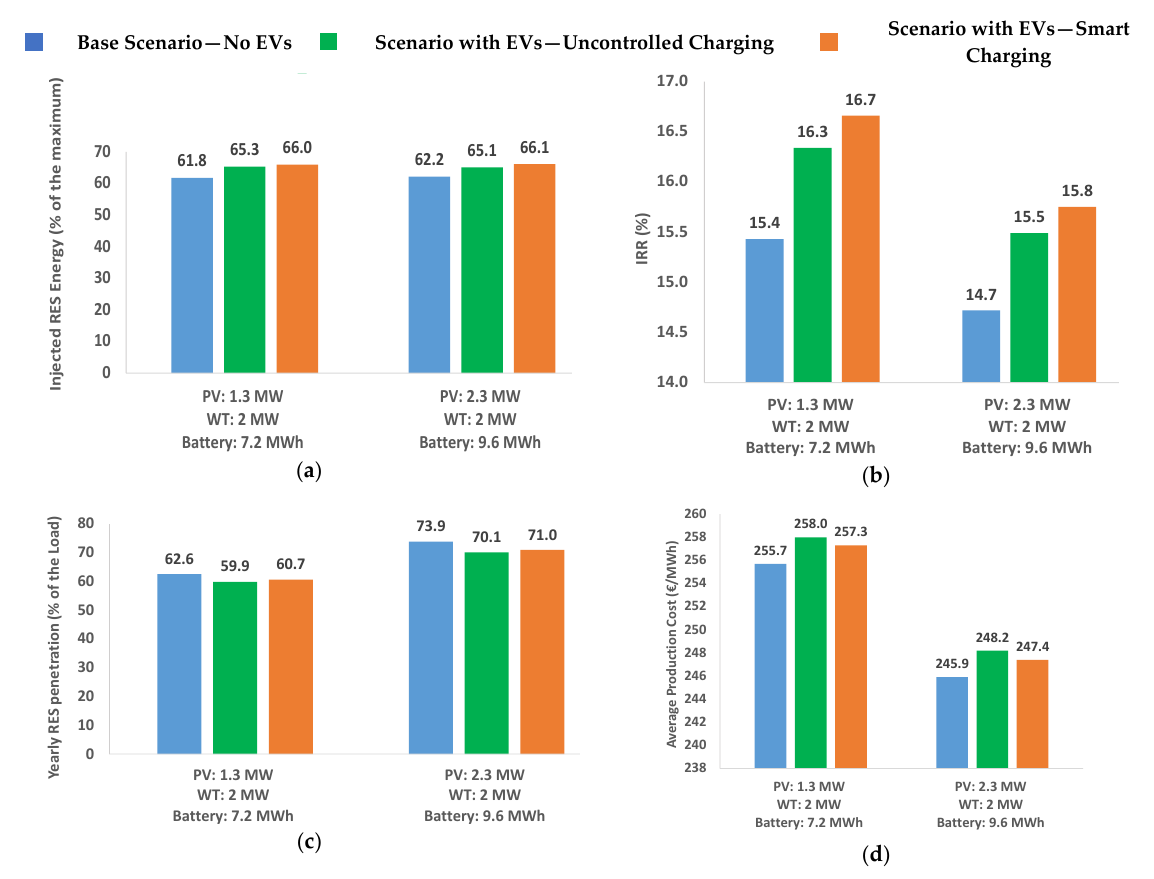
Figure 4. The impact of EV charging in Astypalea [45] regarding ( a ) injected RES energy (% of the maximum available), ( b ) IRR, ( c ) RES penetration (% of the system’s demand), and ( d ) average production cost [45].